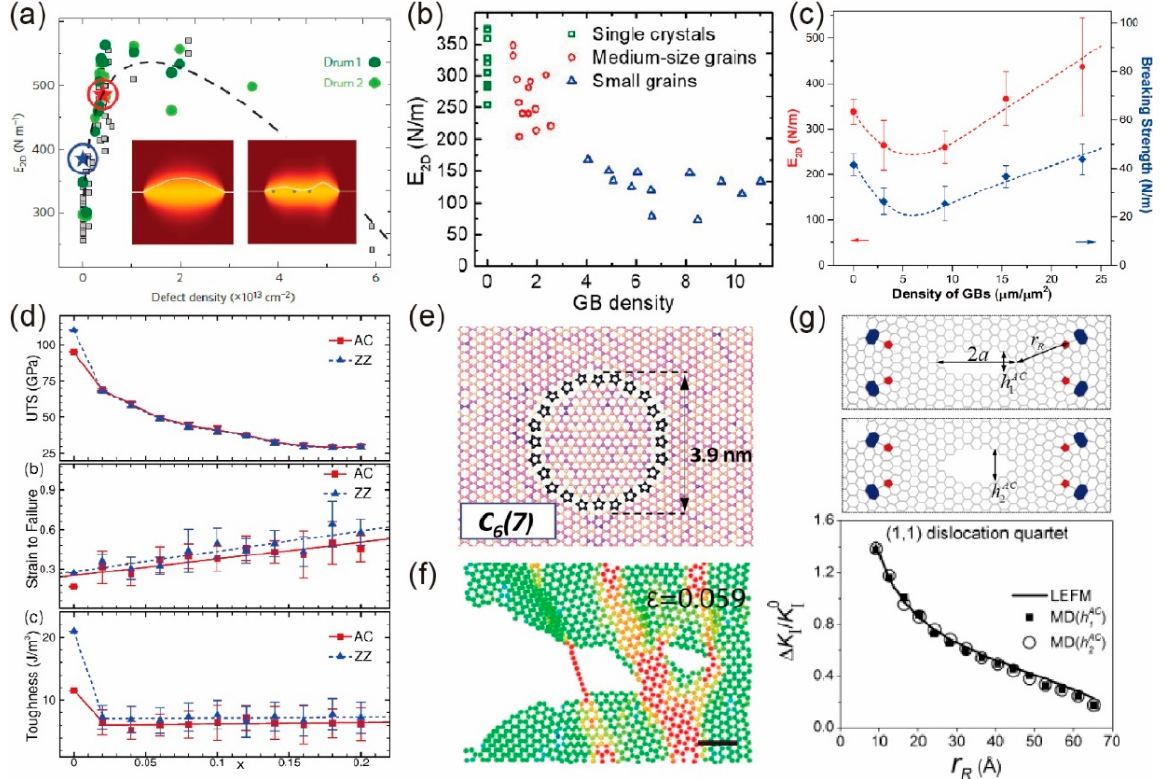
Figure 6. In-plane mechanical properties of defective graphene monolayer. ( a ) 2D elastic modulus of monolayer graphene as a function of vacancy density observed in the experiments. Adapted and reprinted with permission from [20]. ( b ) 2D elastic modulus as a function of GB density. Adapted and reprinted with permission from [98]. ( c ) 2D elastic modulus and strength as a function of GB density. Adapted and reprinted with permission from [100] ( d ) Strength, failure strain, and toughness of vacancy defected monolayer graphene as a function of vacancy density. Reprinted with permission from [97]. ( e ) Flower-like grain boundary. Reprinted with permission from [101]. ( f ) Atomic-scale crack bridging. Reprinted with permission from [102]. ( g ) Shielding effect of dislocation to crack propagation. Reprinted with permission from